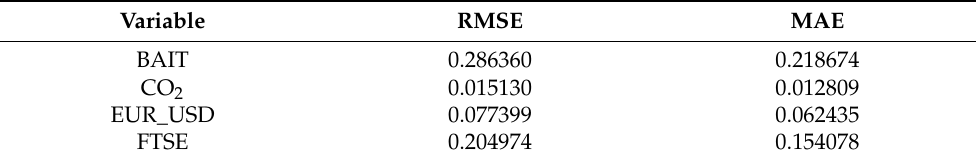
Table 4. B-VAR forecast statistics of the different prior distributions for the model